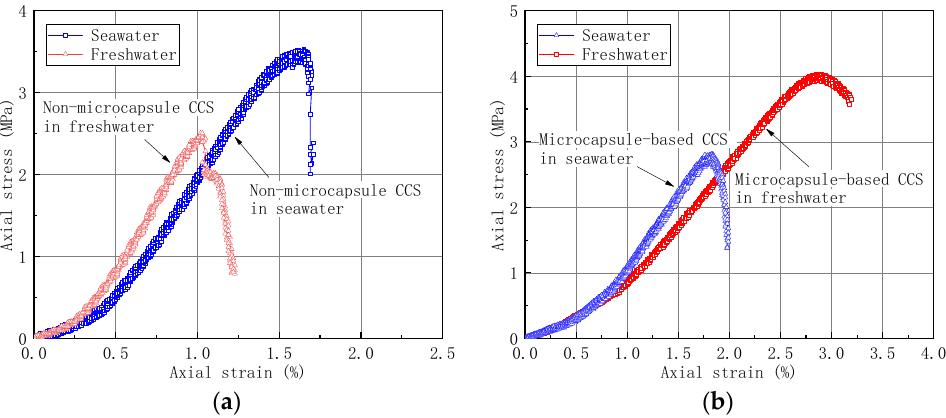
Figure 6. Comparison of compressive strength of freshwater mixed and seawater mixed specimens: ( a ) microcapsule content = 0%; ( b ) microcapsule content = 3%.